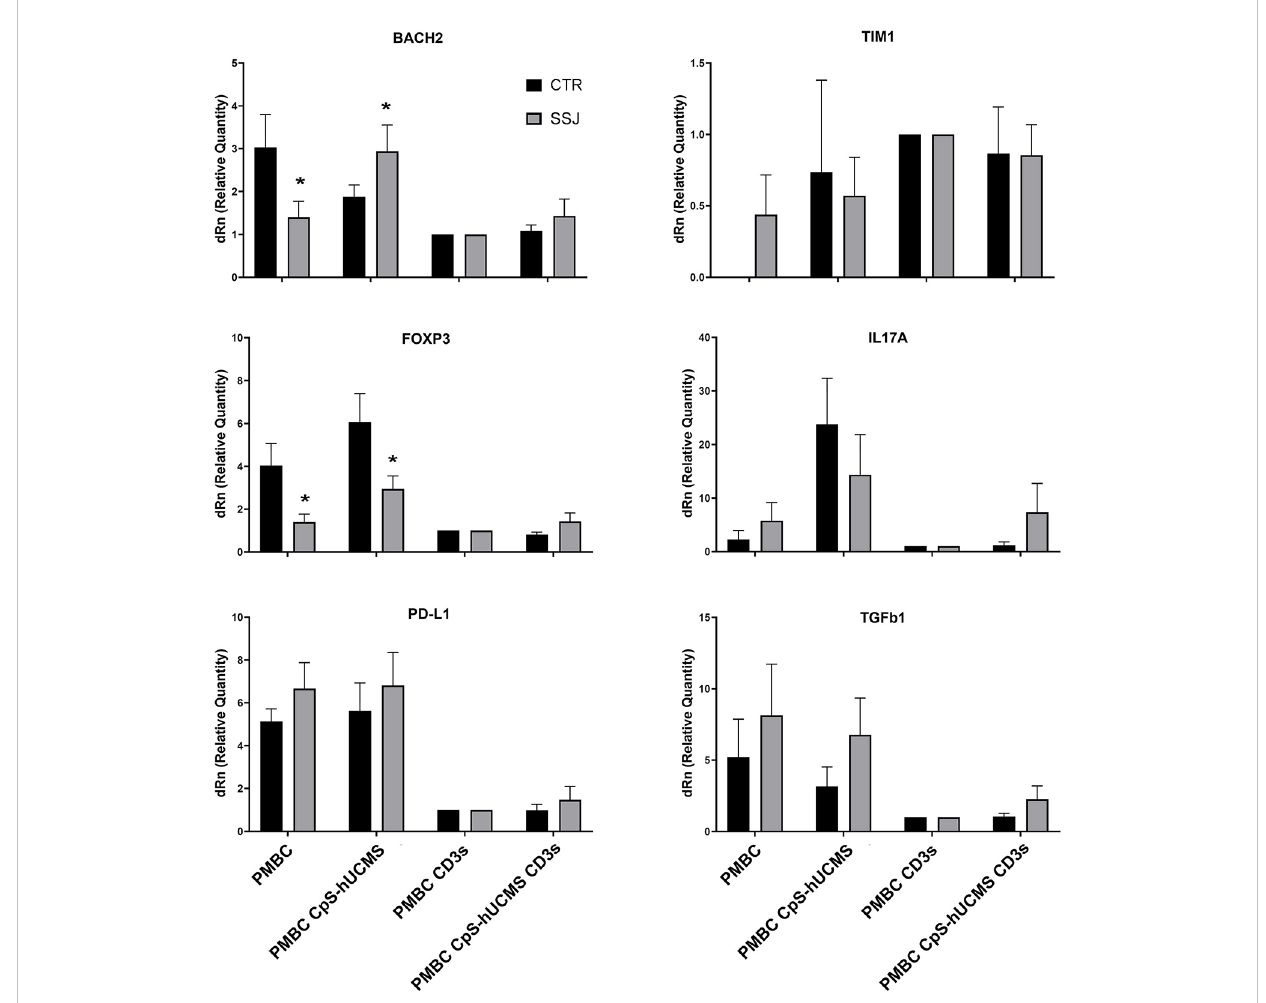
FIGURE 2 qPCR for indicated messengers expressed byPBMC of control and Sjogren patients after 5 days of culture with or without CpS-hUCMS (pretreated with IFN g 2400 U/10 6 cells) and with or without CD3. The expression of each marker was calculated by assigning PBMC+CD3s with the arbitrary value 1. HPRT1 served for control. All results were expressed as mean ± SEM